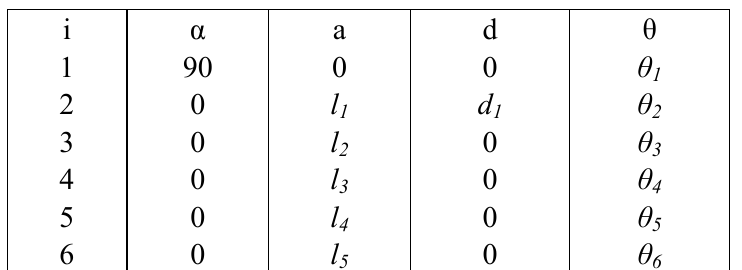
Table 1. Link parameters of the